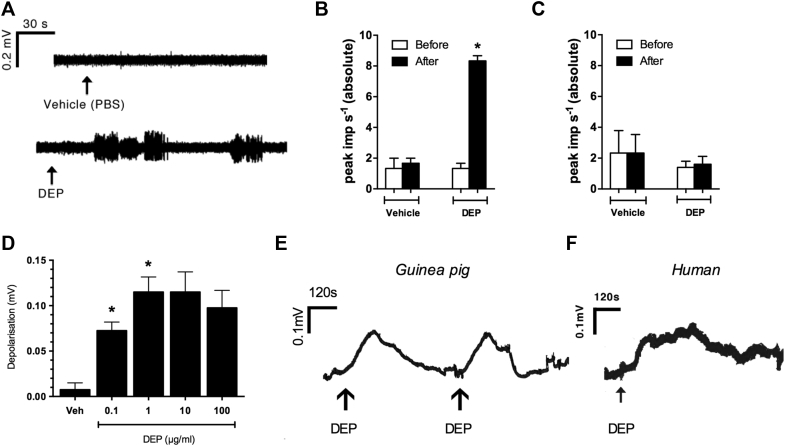
DEPs activate airway sensory afferents. A, Representative trace of action potential firing induced by vehicle (PBS) or DEPs (10 μg/mL administered intratracheally) recorded from a guinea pig and airway C-fiber afferent. B and C, Peak action potential impulses induced by vehicle (PBS) or DEPs in airway C-fiber (n = 3; Fig 1, B) and Aδ-fiber (n = 4; Fig 1, C) afferents. *P < .05, paired t test. D, DEP concentration response in isolated vagus nerve (n = 4). *P < .05, repeated-measures 1-way ANOVA with the Dunnett post hoc test compared against vehicle. E, Representative trace of depolarization induced by DEPs (1 μg/mL) in isolated guinea pig vagus nerve. F, Representative trace of depolarization induced by DEPs (1 μg/mL) in isolated human vagus nerve. Data in histograms are expressed as means ± SEMs.